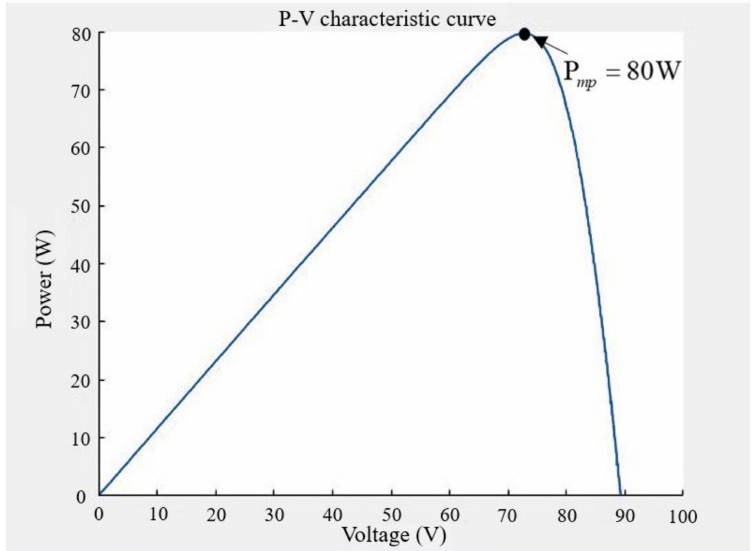
Figure 4. P–V characteristic curve simulation for Case 1.